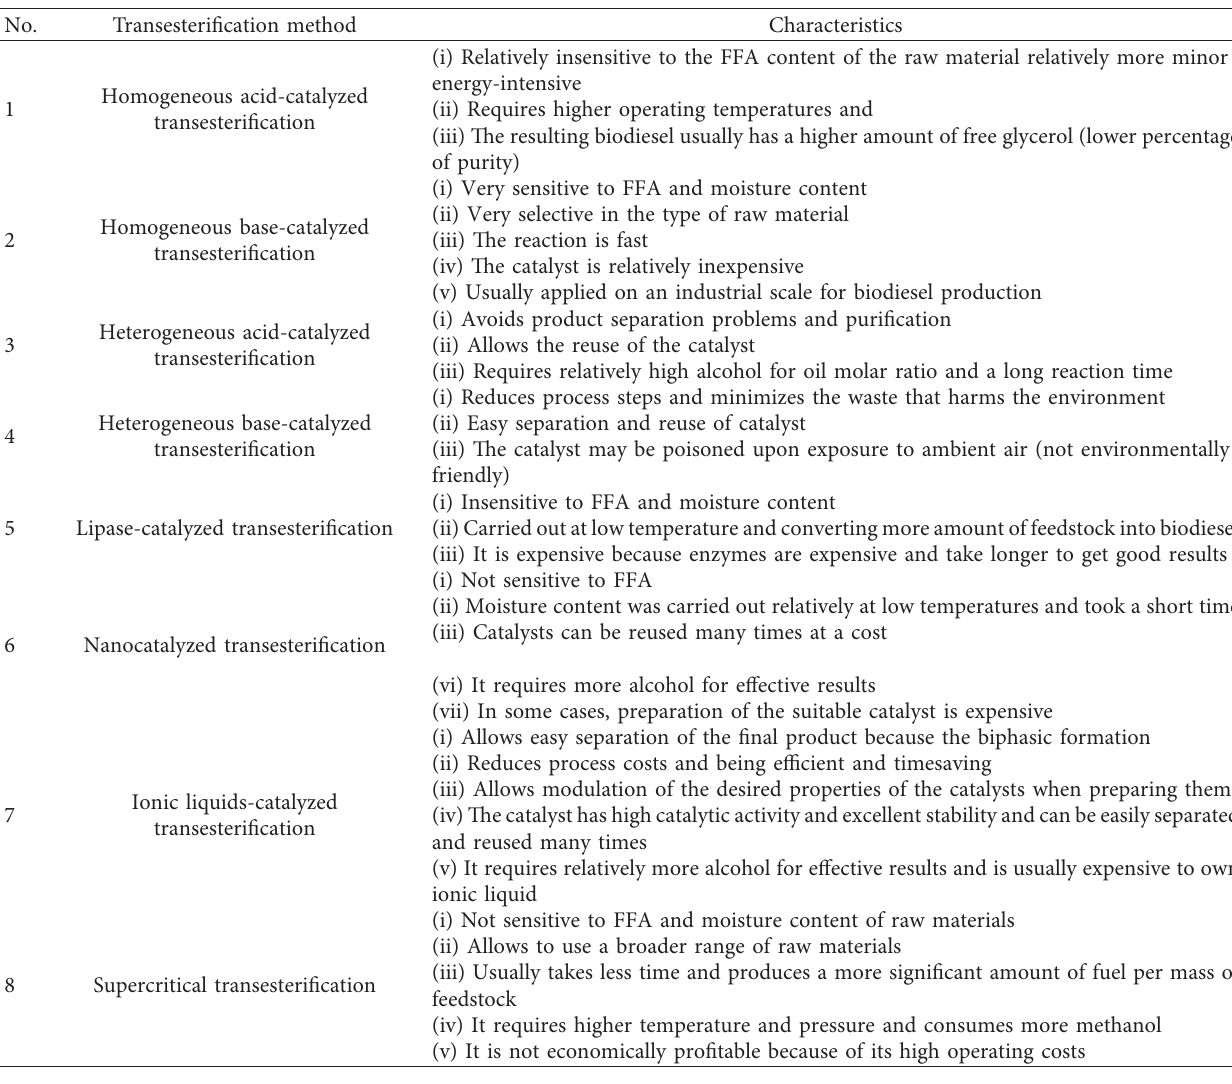
Table 4: Different types of transesterification method